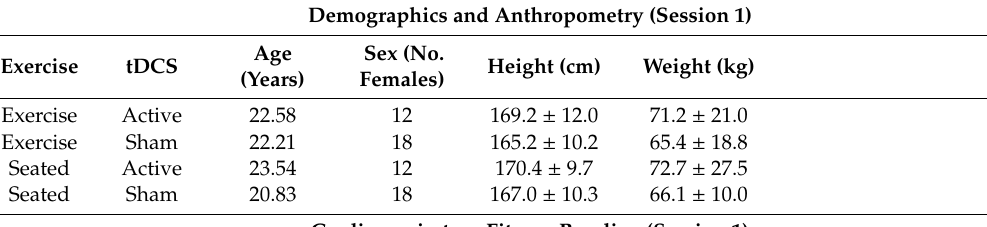
Table 1. Descriptive statistics of participants’ demographics, anthropometry, baseline cardiorespiratory fitness, and tDCS expectations and